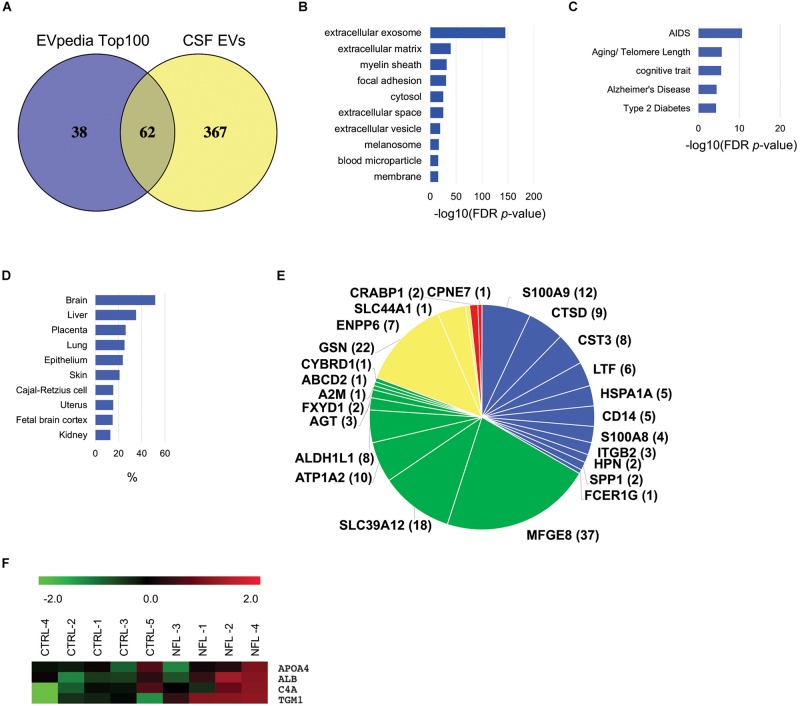
Bioinformatic characterization of former NFL players CSF-derived EV proteome dataset: (A) Venn diagram of the 429 proteins identified in CSF-derived EV and EVpedia Top 100. (B) Gene Ontology (GO) analysis using DAVID Bioinformatics Resources 6.8. The GO term of Top10 Cellular Component with –log10 (FDR p-value). (C) The GO term of Top5 Disease Ontology with –log10 (FDR p-value). (D) The GO term of Top10 Tissue Expression Ontology with% enrichment. (E) Enrichment of brain cell-specific markers in CSF-derived EV proteins. The brain cell-specific markers were searched using Barres Brain RNA-Seq datasets. Blue: Microglia, Green: Astrocytes, Yellow: Oligodendrocytes, Red: neurons. The parentheses show the number of identified peptides by LC-MS/MS. (F) Heatmap of EV proteins in individual proteome dataset. Each row in the heat map show a protein, and each column represent CTRL and former NFL players. Red indicate up-regulate expression and Green show down-regulate.